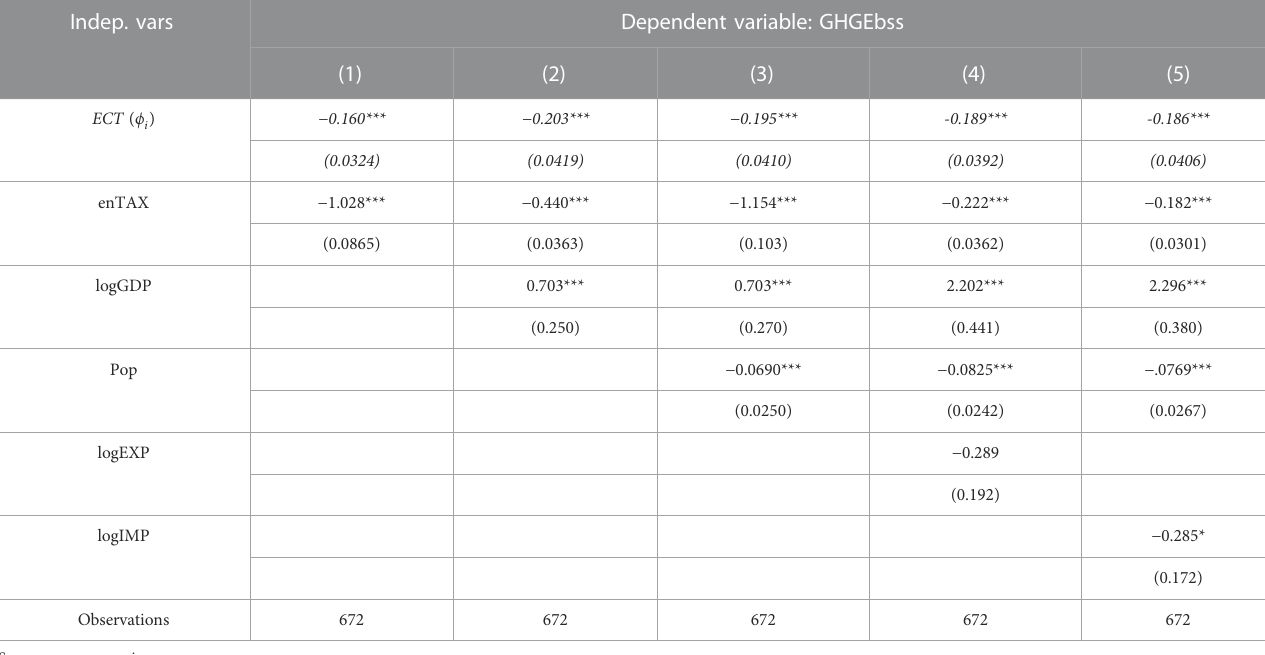
TABLE 3 Pooled mean group (PMG) results, ECT and long-run coef fi cients. Indep. vars